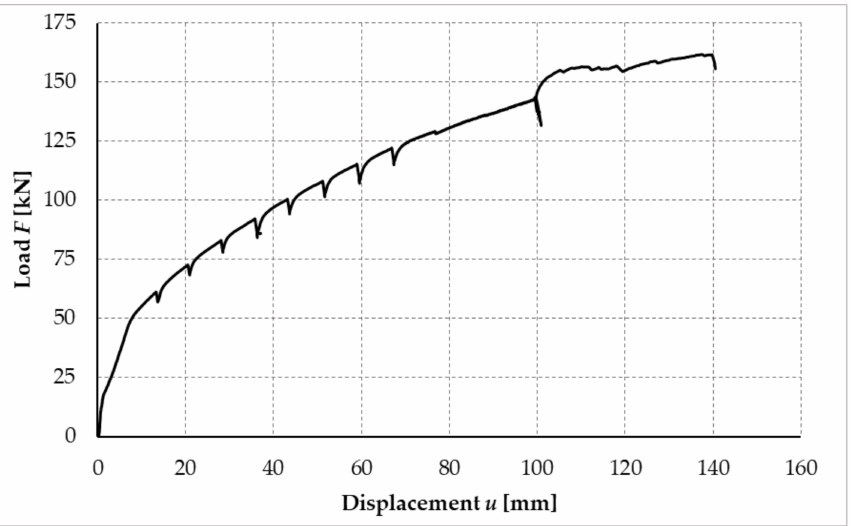
Figure 26. Deformation of the frame joint after separation of deformation components, test sample no.